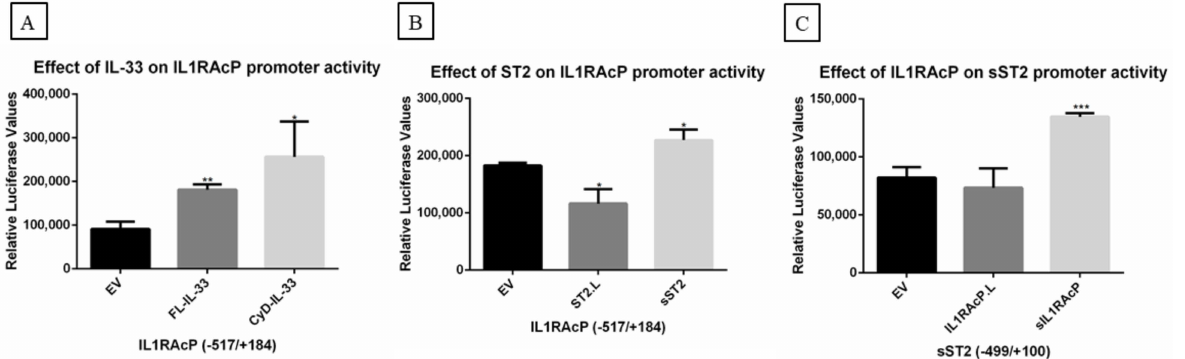
Figure 8. The effect of IL-33, ST2/IL1RL1, and IL1RAcP on IL-33/ST2-IL1RAcP complex promoters. MCC13 cells were transiently co-transfected with IL-33, ST2/IL1RL1, IL1RAcP, or the empty vector (EV) as control expression plasmids. The promoter fragments spanning nucleotides for ( A , B ) IL1RAcP and ( C ) sST2/sIL1RL1 were − 517/+184, and − 499/+100, respectively. Each bar represents the average of three independent parallels ± SD. The experiment was repeated 3 times. Luciferase values were normalized with a total protein in each sample. * p ≤ 0.05, ** p ≤ 0.01, and *** p ≤